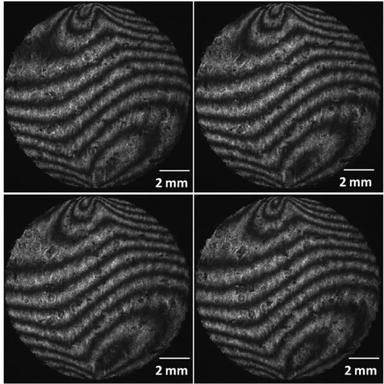
Images of phase shifting.